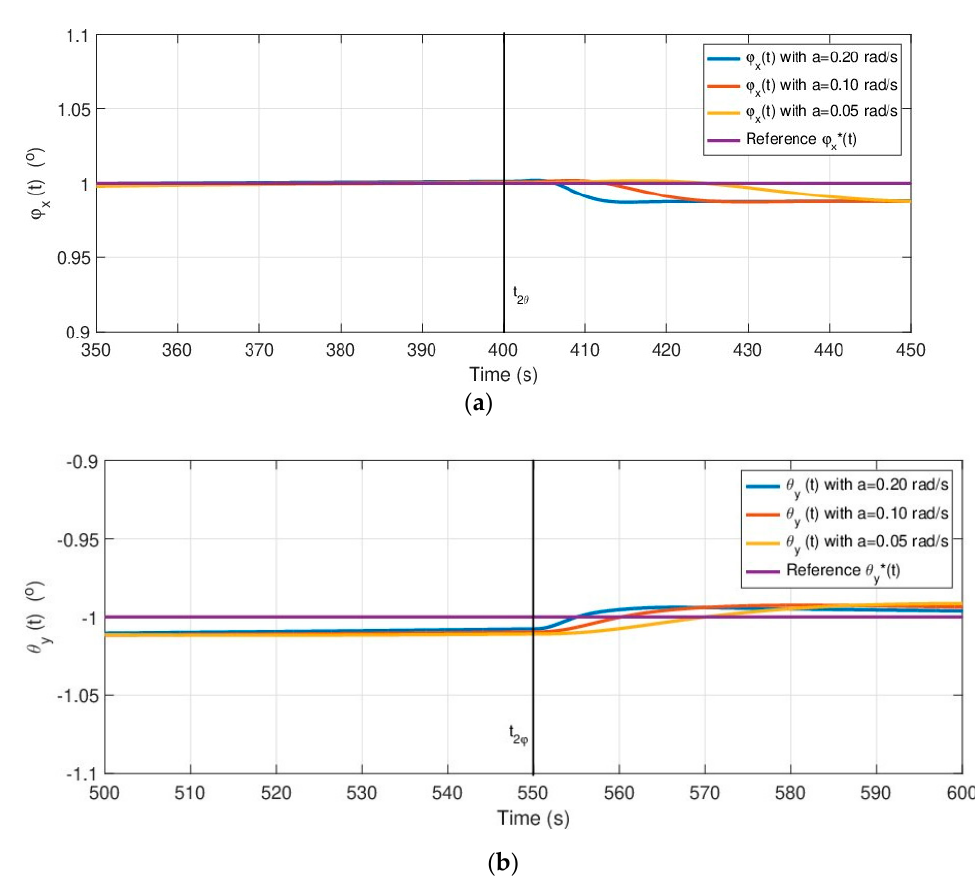
Figure 13. Zoom of step responses for different gains of the controllers. ( a ) Zoom of the ϕ x responses in the neighborhood of the instant t 2 θ = 400 s. ( b ) Zoom of the θ y responses in the neighborhood of the instant t 2 ϕ = 550